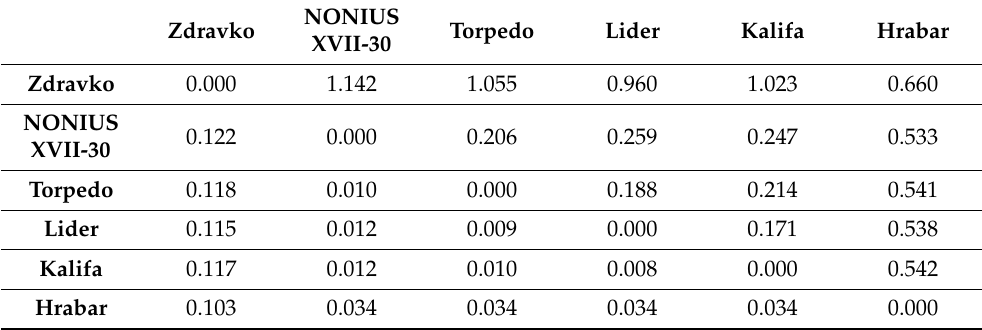
Table 5. Pairwise population matrix of Nei’s genetic distances (above the diagonal) and pairwise population F ST values (below the diagonal) between six sire genealogical